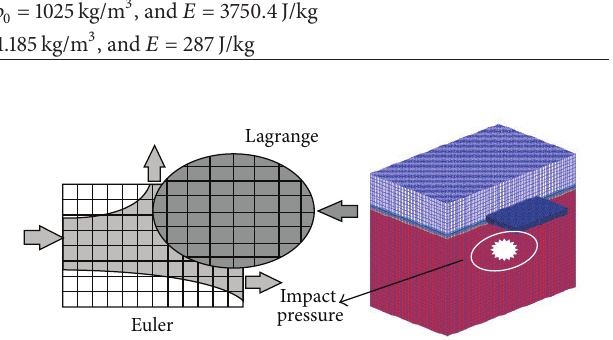
Figure 7: General Coupling function and LCSP-UNDEX bubble simulation